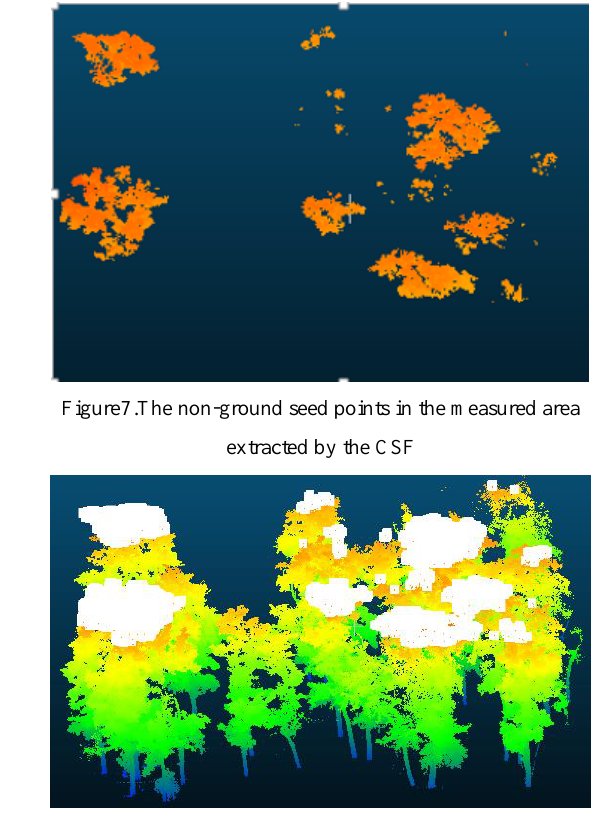
Figure 5.The non-ground point in the measured area filtered by the CSF(superimposed on source data)